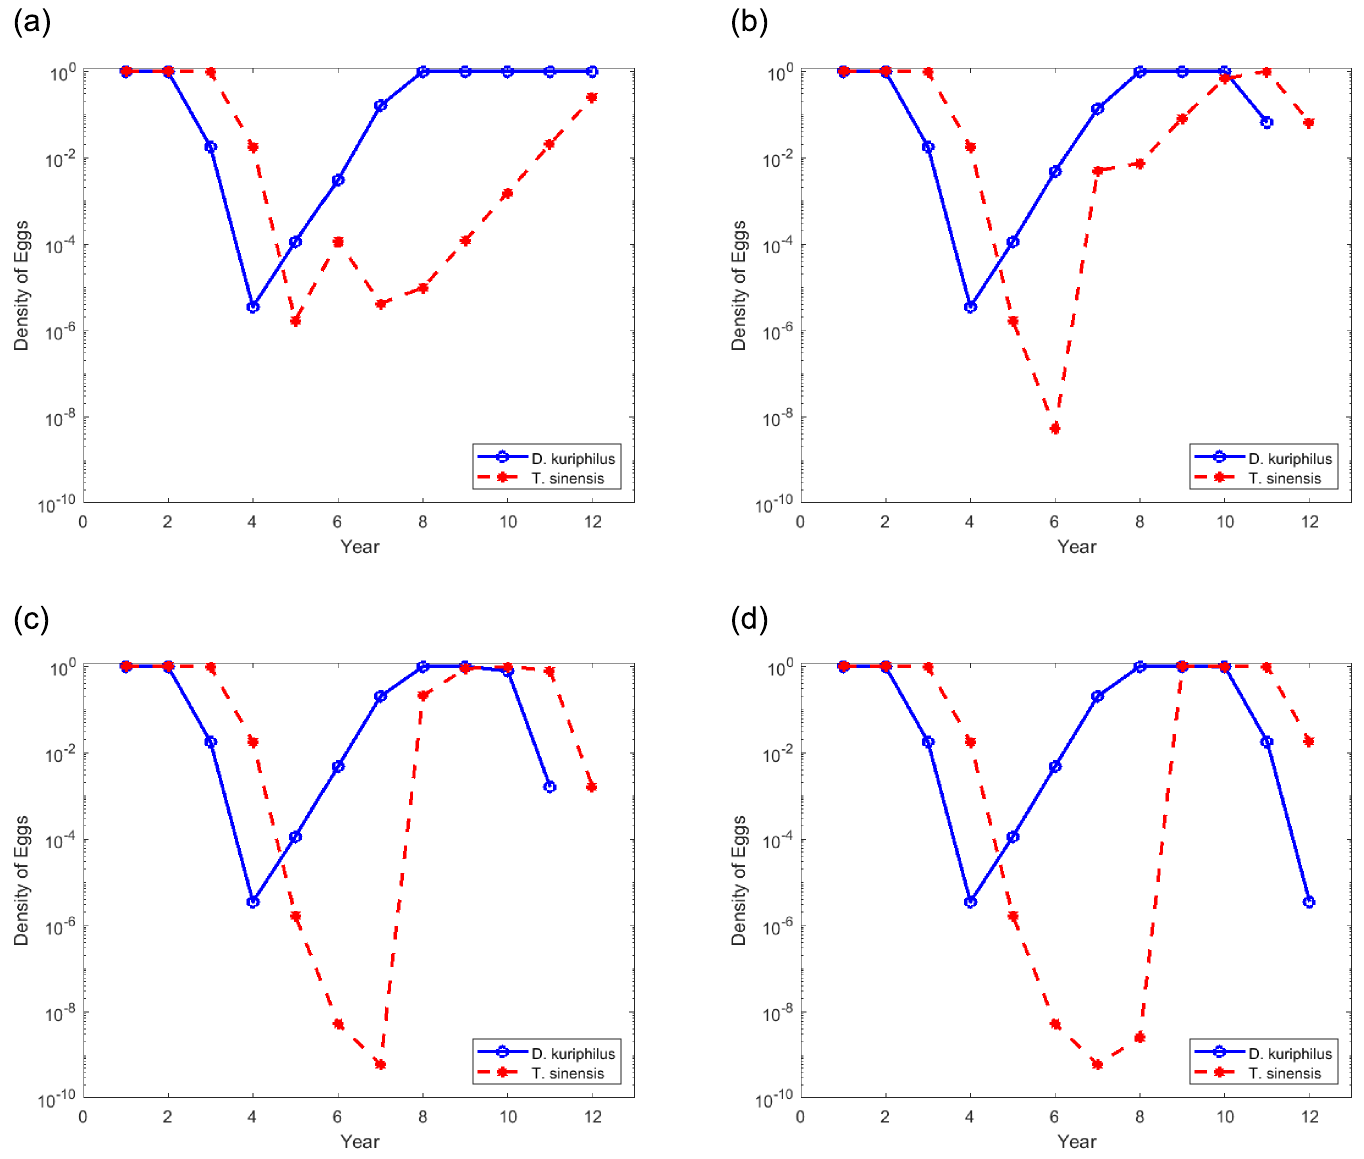
Fig 8. Egg density of D. kuriphilus ( v years 1 and n r according to a regular mesh 4 ×